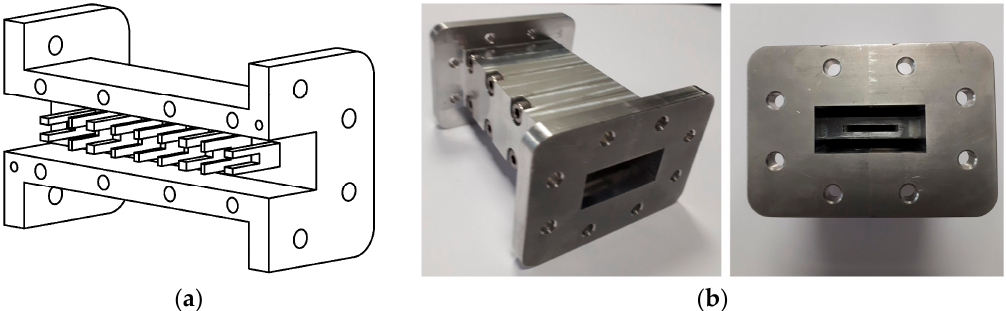
Figure 12. Mechanical design and manufactured Rx filter. ( a ) Sketch of half Rx filter, ( b ) pictures of the manufactured Rx filter before silver plating.